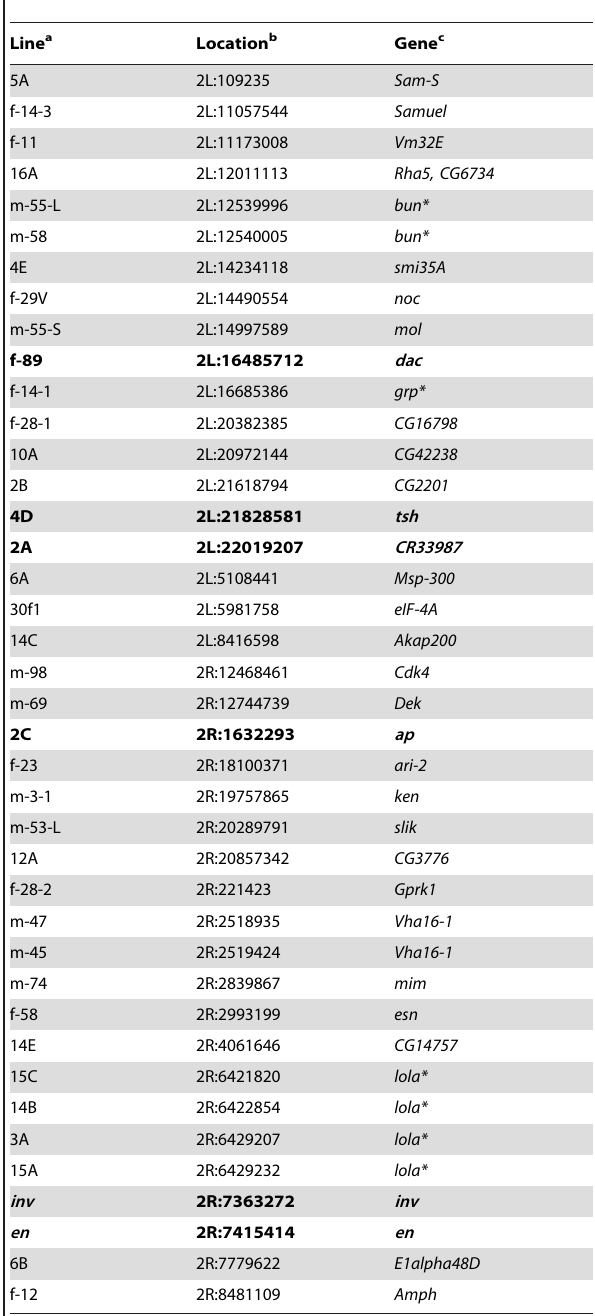
Table 2. Insertions near en/inv on chromosomes carrying en D 1.5 .